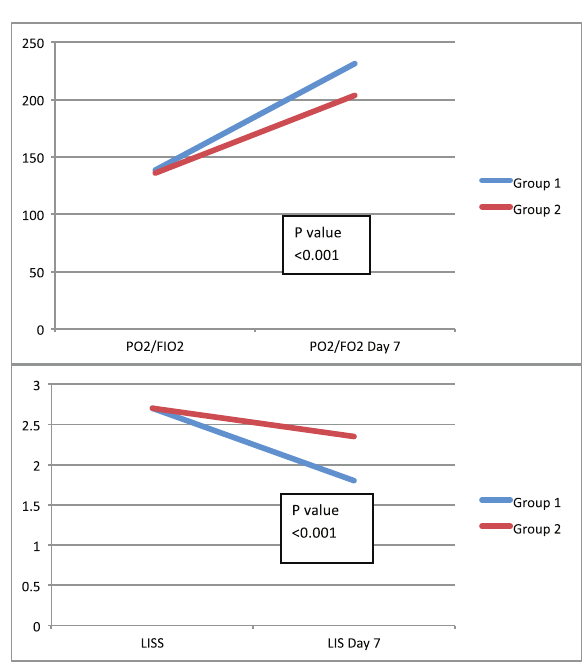
Comparison between two groups regarding their changes of PO 2 / FiO 2 and LISS. PaO 2 , arterial partial oxygen pressure; FiO 2 , fraction of inspired oxygen; LISS, lung injury severity score.